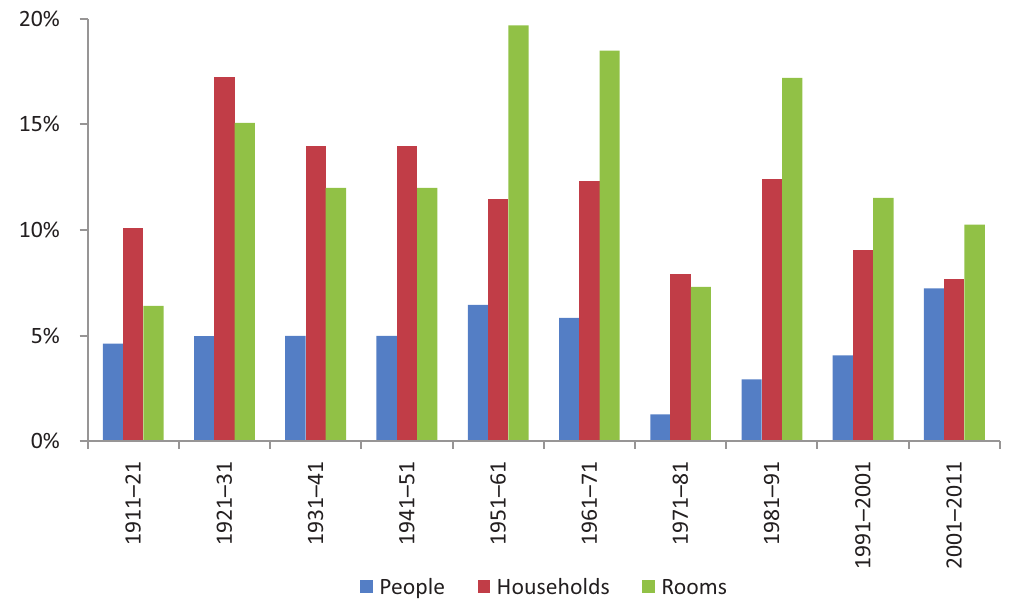
Figure 1. Rate of growth in number of people, households and rooms, England and Wales, 1911–2011. Compiled by the author based on data from Casweb for 1981 and Nomisweb for 2011. There was no census in 1941 due to WWII, so data for 1931–1941 and 1941–1951 are based on averaging data for